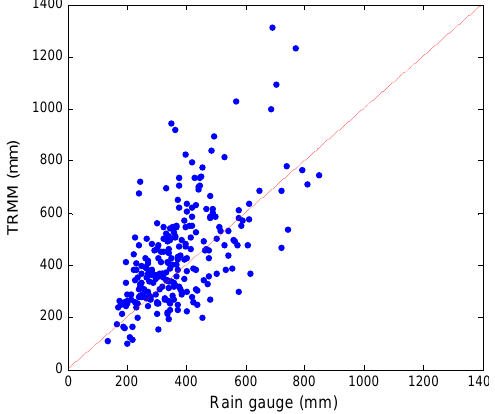
Figure 9. The overall scatterplot between TRMM and rain gauges at annual time scale.